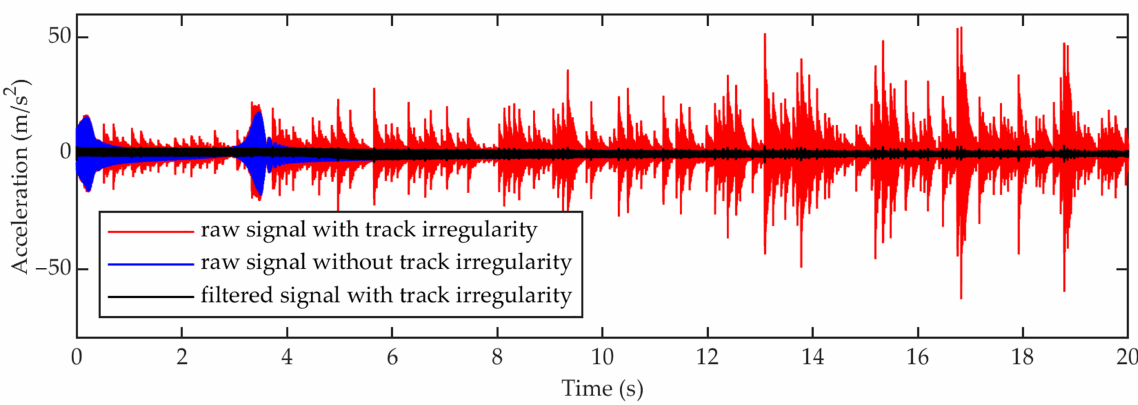
Figure 13. The comparison of the time histories of the fi rst gearbox housing under traction condition.